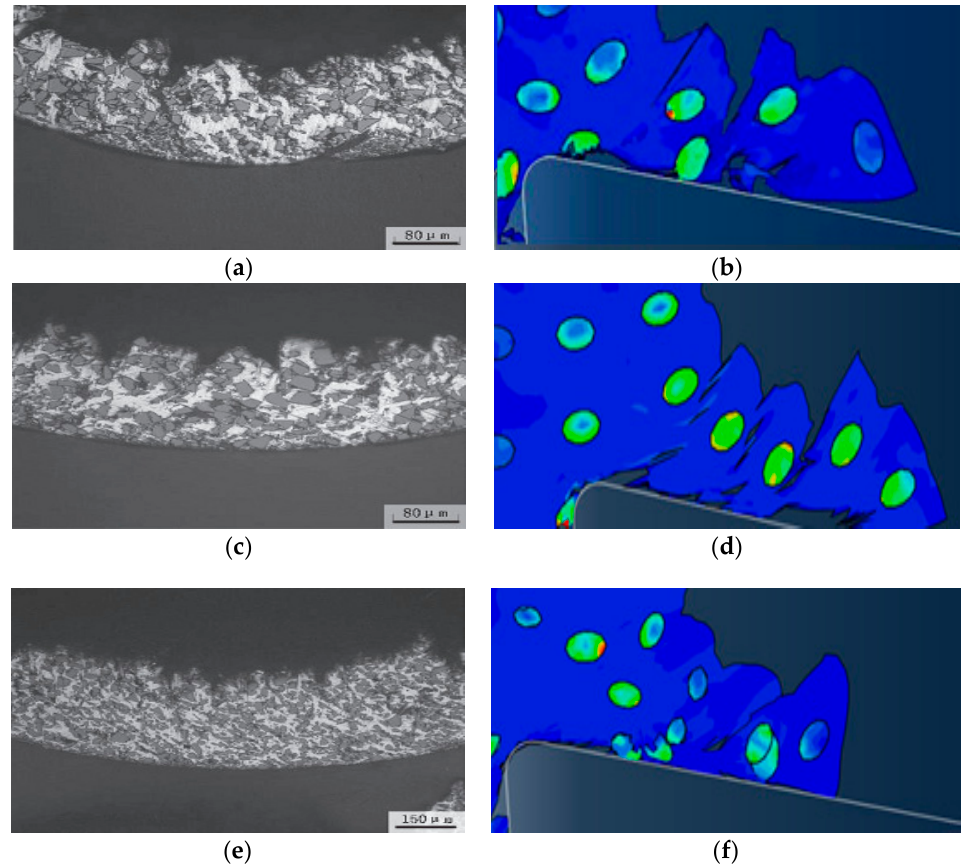
Figure 29. shows the different cutting speeds compared to the effects of two feed rates on machining chip morphology and simulated chips morphology; chips obtained by machining the 2024Al/SiC-30 μ m composite under various feed rates and cutting speeds and comparing SiCp/Al with simulated chips ( a ) shows chips at v c = 47 m/min and f = 0.1 mm/rev ( b ) shows simulated chips at v c = 40 m/min and f = 0.1 mm/rev, ( c ) shows chips at v c = 120 m/min and f = 0.1mm/rev, ( d ) simulated chips v c = 100 m/min and f = 0.1 mm/rev, ( e ) shows chips at v c = 120 m/min and f = 0.2 mm/rev, and ( f ) simulated chips at v c = 100 m/min and f = 0.2 mm/rev; ( a , c , e ) Adapted with permission from ref. [50] Copyright 2018, Elsevier.